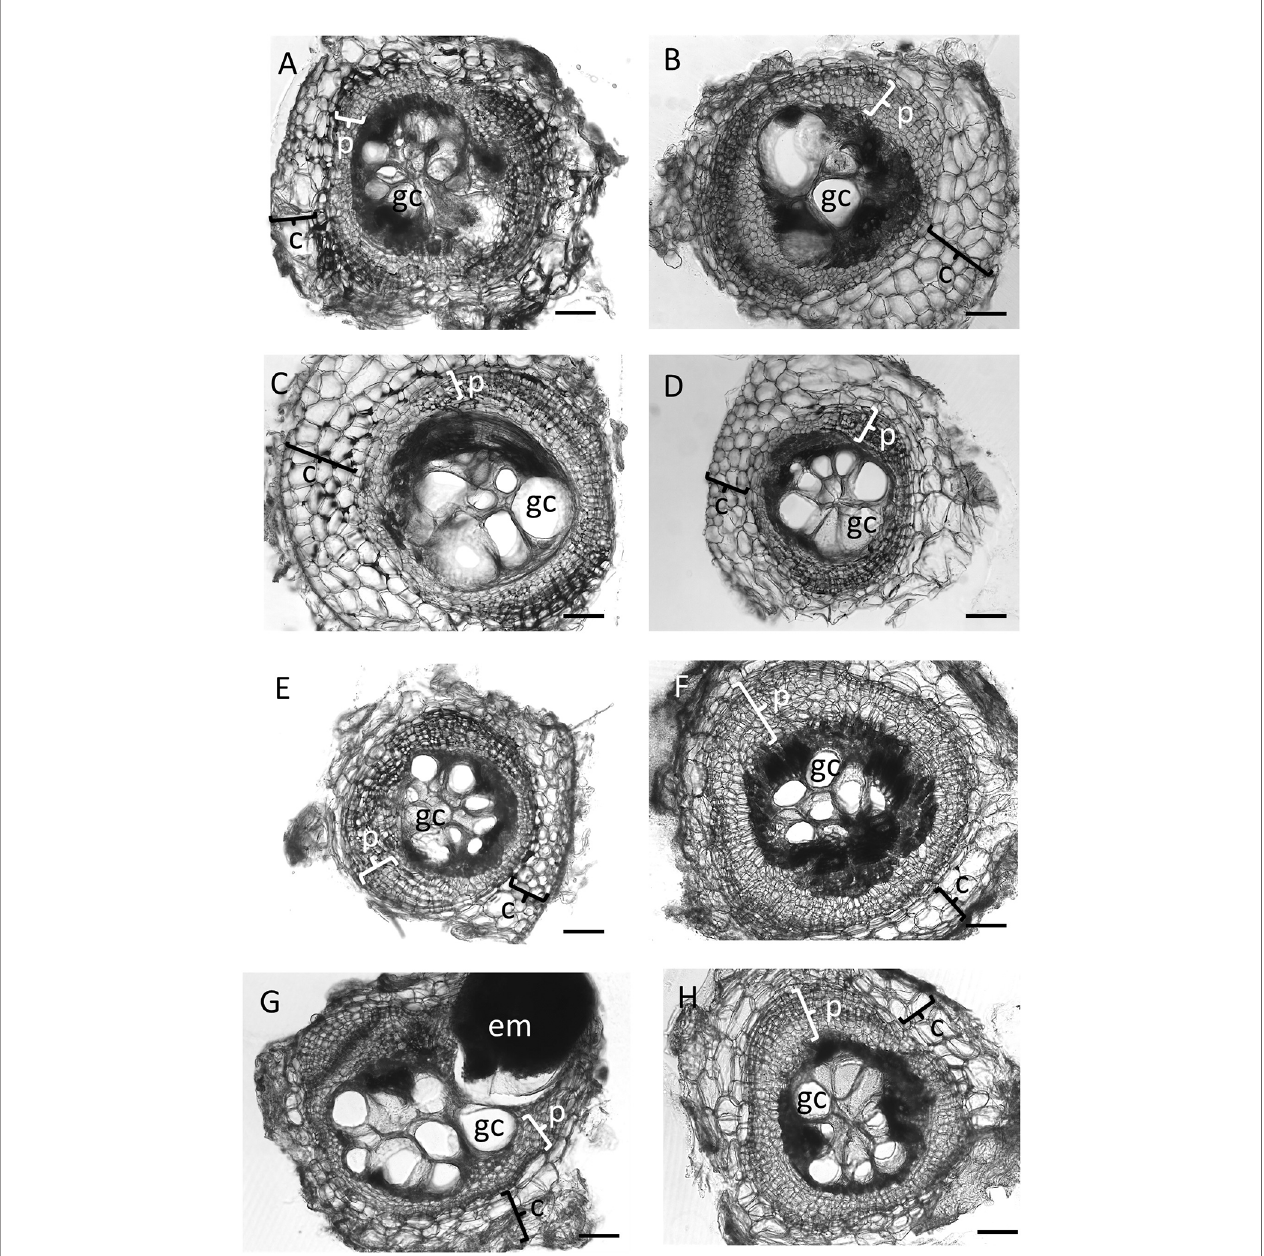
FIGURE 1 | Cross sections of galls of wild-type Medicago truncatula A17 and nodulation mutants at 35 days post inoculation with Meloidogyne javanica. All photos were taken at the same magni fi cation and the scale bar represents 200 µm. In total, fi ve galls were sectioned from every genotype, and similar results were found for all fi ve galls; thus these examples are representative of the replicates. (A) Gall section of M. truncatula A17, (B) nfp1 , (C) nin1 , (D) nsp2-2, (E) cre1 , (F) latd/nip , (G) skl (H) sunn4 mutants. Typical features of a gall are labeled as follows: c, cortex, occasionally showing divisions; em, egg mass; gc, giant cell (only one giant cell is labeled per section); p, pericycle, showing multiple layers following